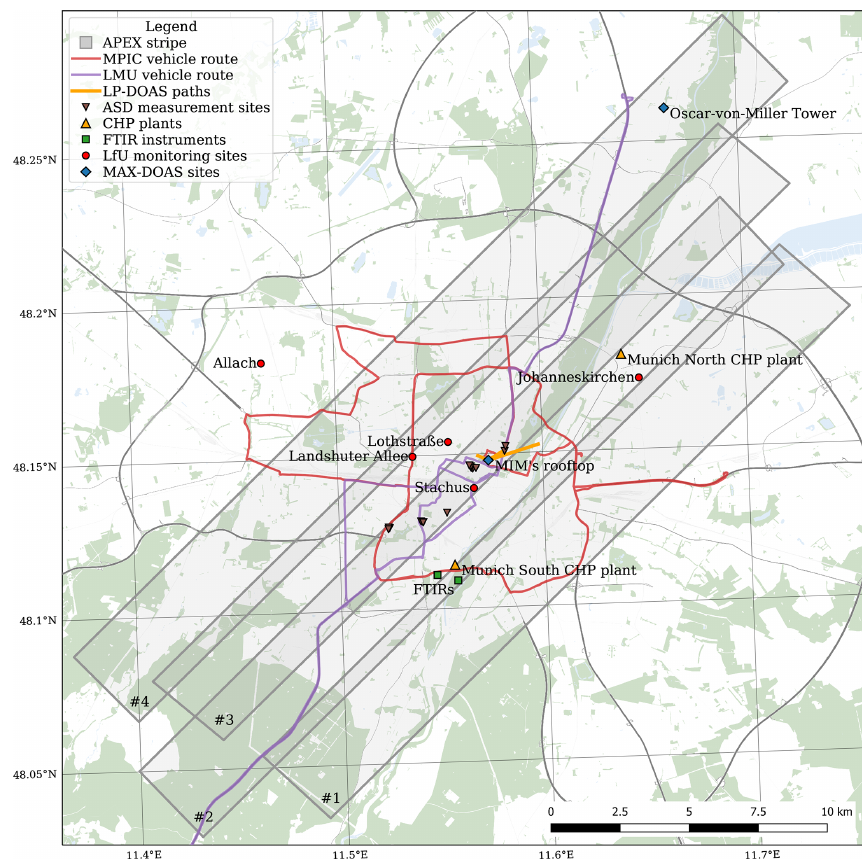
Figure 1. Map of Munich with overlaid APEX flight stripes (nos. 1–4), routes taken by the LMU and MPIC vehicles in the afternoon of 7 July 2016, as well as locations of combined heat and power (CHP) plants, Fourier transform infrared (FTIR) instruments, LfU monitoring sites, and stationary MAX-DOAS instruments and the locations of surface reflectance measurements with the ASD instruments. Map data from © OpenStreetMap contributors 2021. Distributed under the Open Data Commons Open Database License (ODbL)